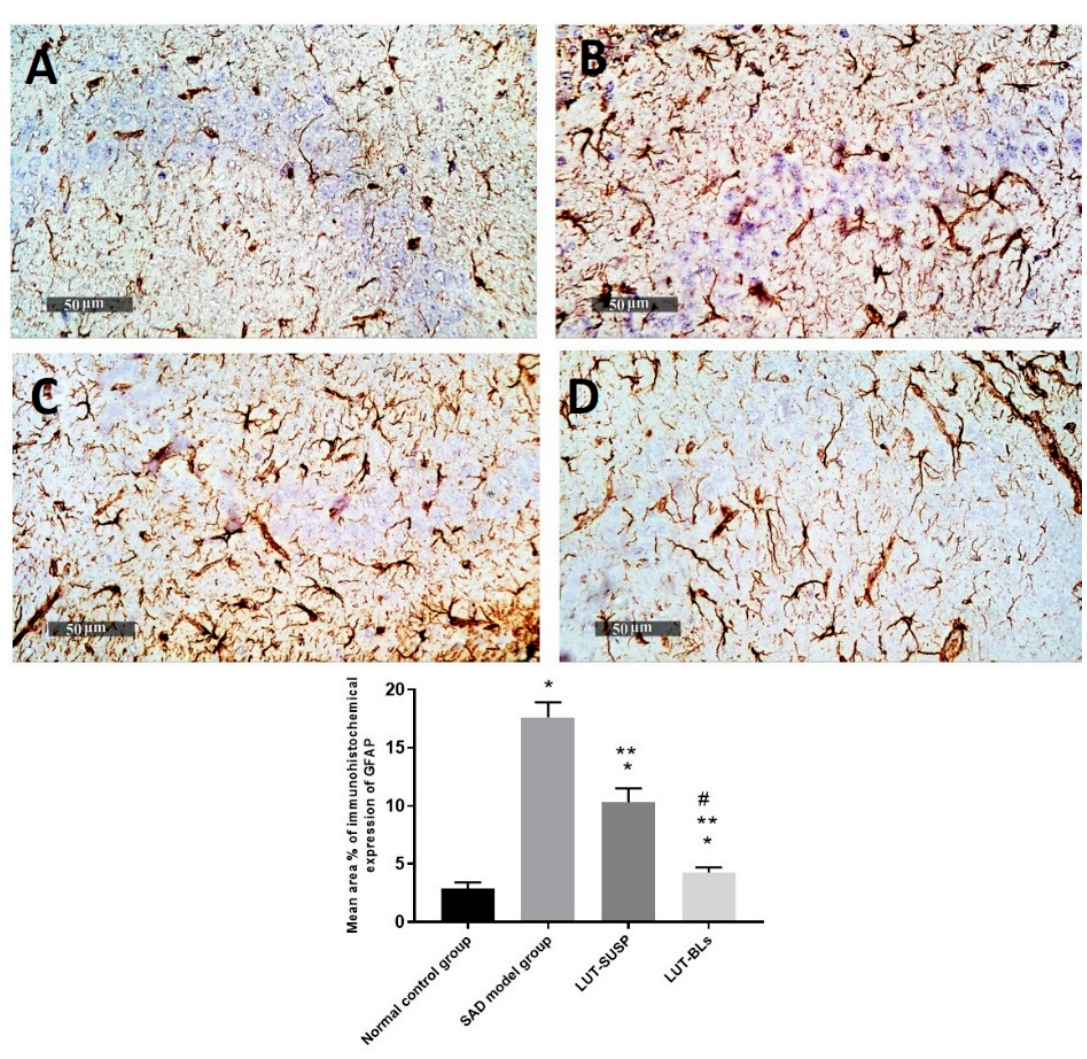
Figure 11. Hippocampal GFAP immunohistochemical expression levels in reactive astrocytes ex- pressed as the mean area percentage of expression. ( A ) normal controls, ( B ) model AD samples, ( C ) LUT suspension samples, and ( D ) LUT-BL samples. Data are expressed as means ± SD. * Statistically significant difference from normal control group, ** statistically significant difference from the SAD model group, and # statistically significant difference from LUT suspension group.